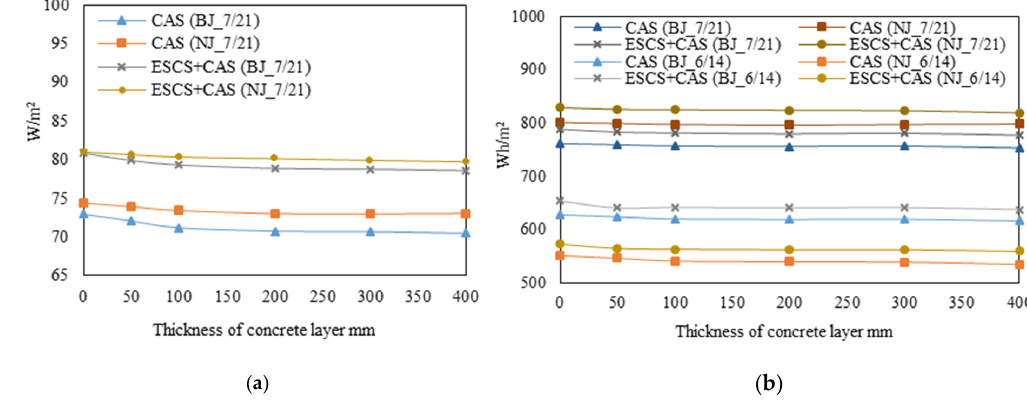
Figure 5. Effects of thermal mass on cooling loads of the combined system. ( a ) Effects of thermal mass on peak cooling loads on design days. ( b ) Effects of thermal mass on accumulated sensible cooling loads on typical days.